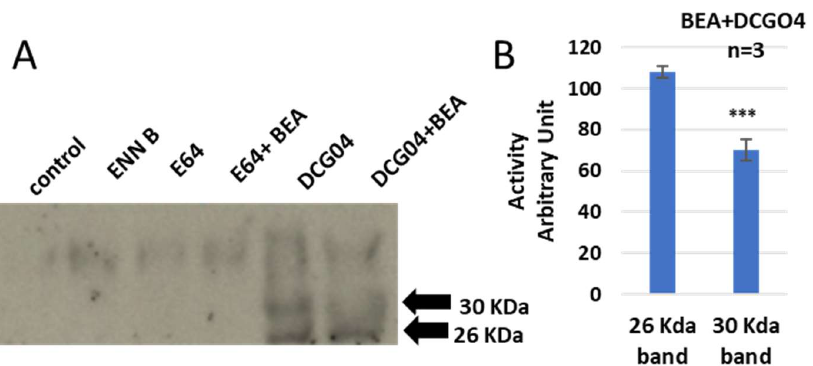
Figure 5. Impact of BEA on the active site labelling of cysteine cathepsins by DCG04. ( A ). Active-site labelling with DCG04 was performed as described in materials and methods. Cells were harvested and proteins were then subjected to protein electrophoresis and Western blotting with streptavidin–horseradish peroxidase. ( B ) Cellular contents of 26 KDa and 30 Kda bands in treated cells with BEA and DCG04 were compared to cells treated with only DCG04. The data were analyzed by t -test and statistics using GraphPad Prism. *** p < 0.001. Graphs are shown as mean ± SE, N = 7.